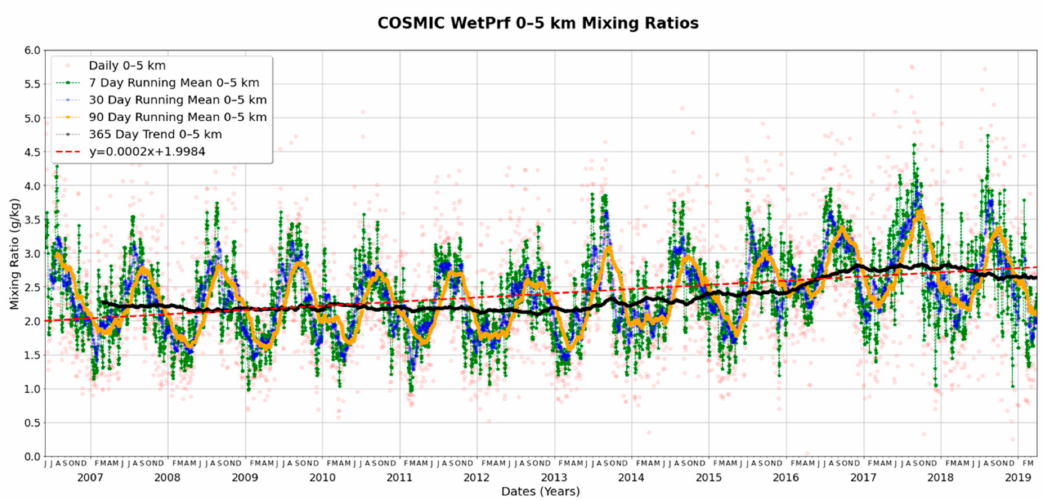
Figure 2. COSMIC Mixing Ratio from 0–5 km in the target domain.